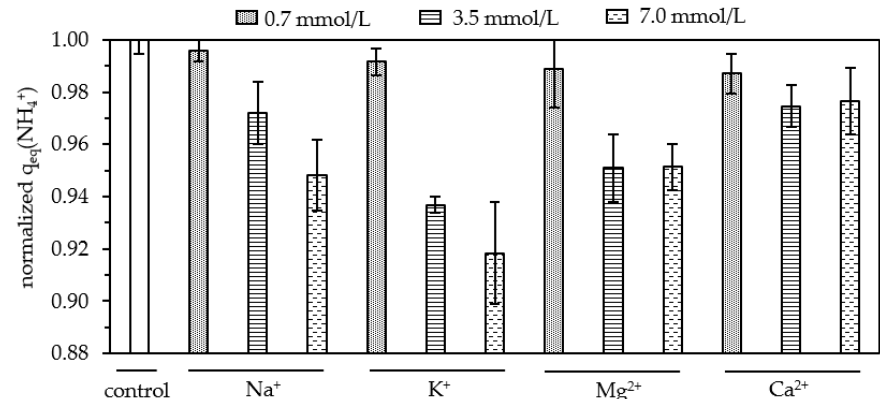
Figure 5. Normalized q eq (NH 4+ ) in the presence of competing cations in three different molar concentrations (matrix: ultrapure water; t eq : 14 d; pH control : 5.9; pH 0 = 6.2; c 0 (NH 4+ ) = 0.71 mmol/L; c 0 (cations) = 0.7, 3.5, 7.0 mmol/L; w / v = 100 g Z /L; T = 22 ◦ C; grain size: 8–16 mm; n = 3).